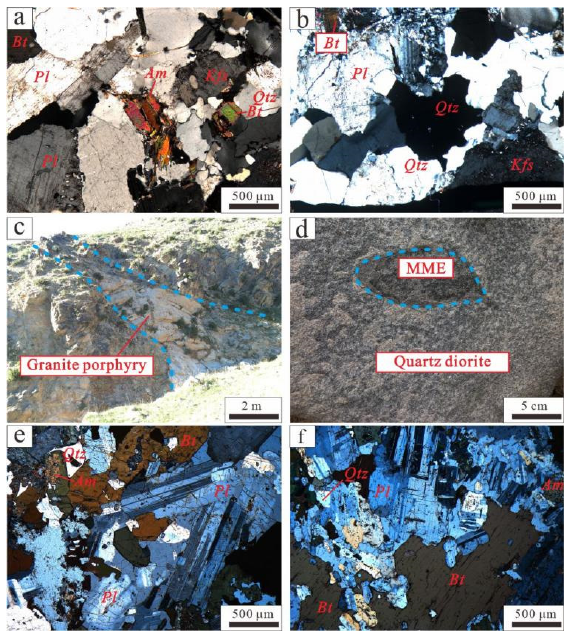
Figure 3. Photographs and photomicrographs of typical lithofacies from the Asiha complex. Photomicrographs of Quartz diorite ( a ). Photomicrographs of granite porphyry ( b ). The typical photographs of the granite porphyry ( c ), quartz diorite and MMEs in the field ( d ). Photomicrographs of MMEs ( e , f ). Pl = plagioclase, Kfs = K-feldspar, Qtz = quartz, Am = amphibole, and Bt = biotite. Granite porphyry has a porphyritic texture and is composed of 40% plagioclase, 35% K–feldspar, 20% quartz, 5%, biotite, and minor zircon and sphene (Figure 3b,c). K-feldspar has Carlsbad twin, and plagioclase has polysynthetic twin. Potassic feldspar has altera- tions such as kaolinization and argillization.